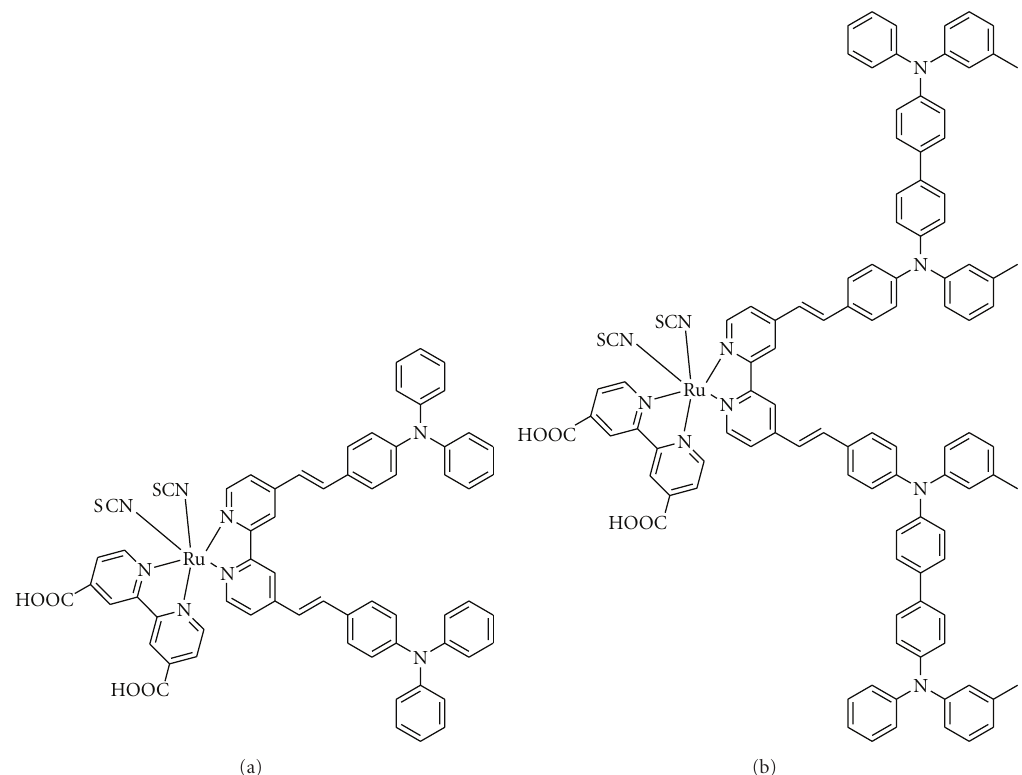
photocurrent density of 21.6 mA cm − 2 and η = 9 . 02%.